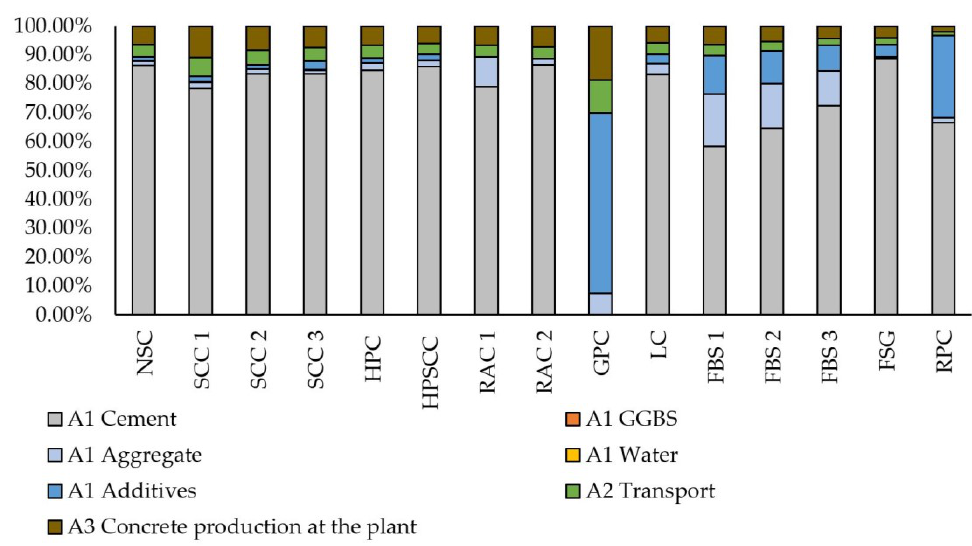
Figure 8. Percentage contribution of concrete mix components as well as A2 and A3 phases in the carbon footprint value.